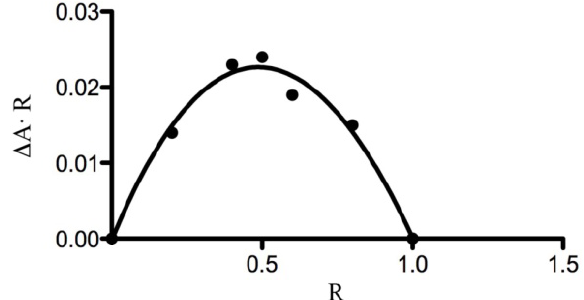
Figure 4. Job plot for the complex FeMeOH: β -CD ( λ = 436